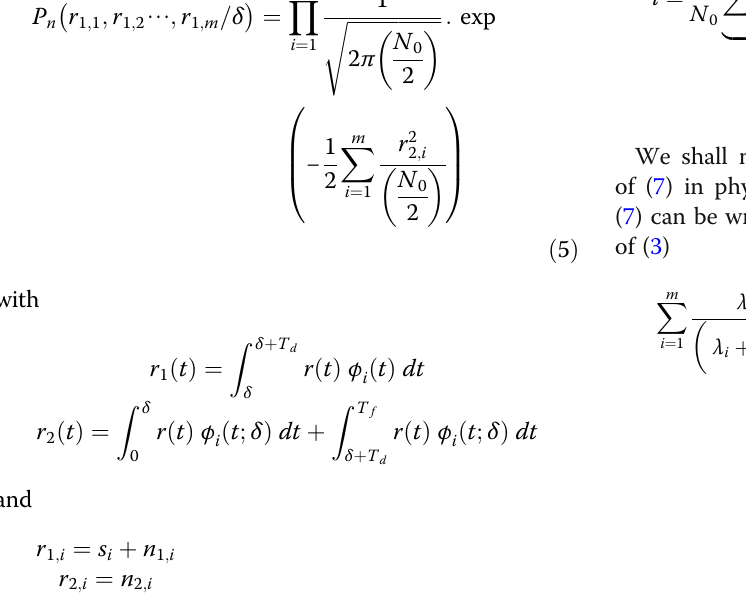
1 ffiffiffiffiffiffiffiffiffiffiffiffiffiffiffiffiffiffiffi